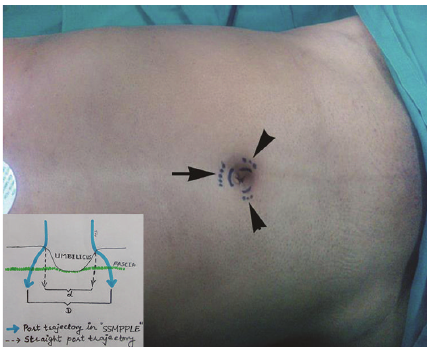
Figure 1: Incisions for port placement. Solid lines indicate the skin incisions and dotted lines indicate the fascial trajectories. This resulted in spacing the trocars away. Inset. Diagrammatic representation of the ports pathways. Note that the intertrocar distance is more with curved paths (D) than with straight (d).